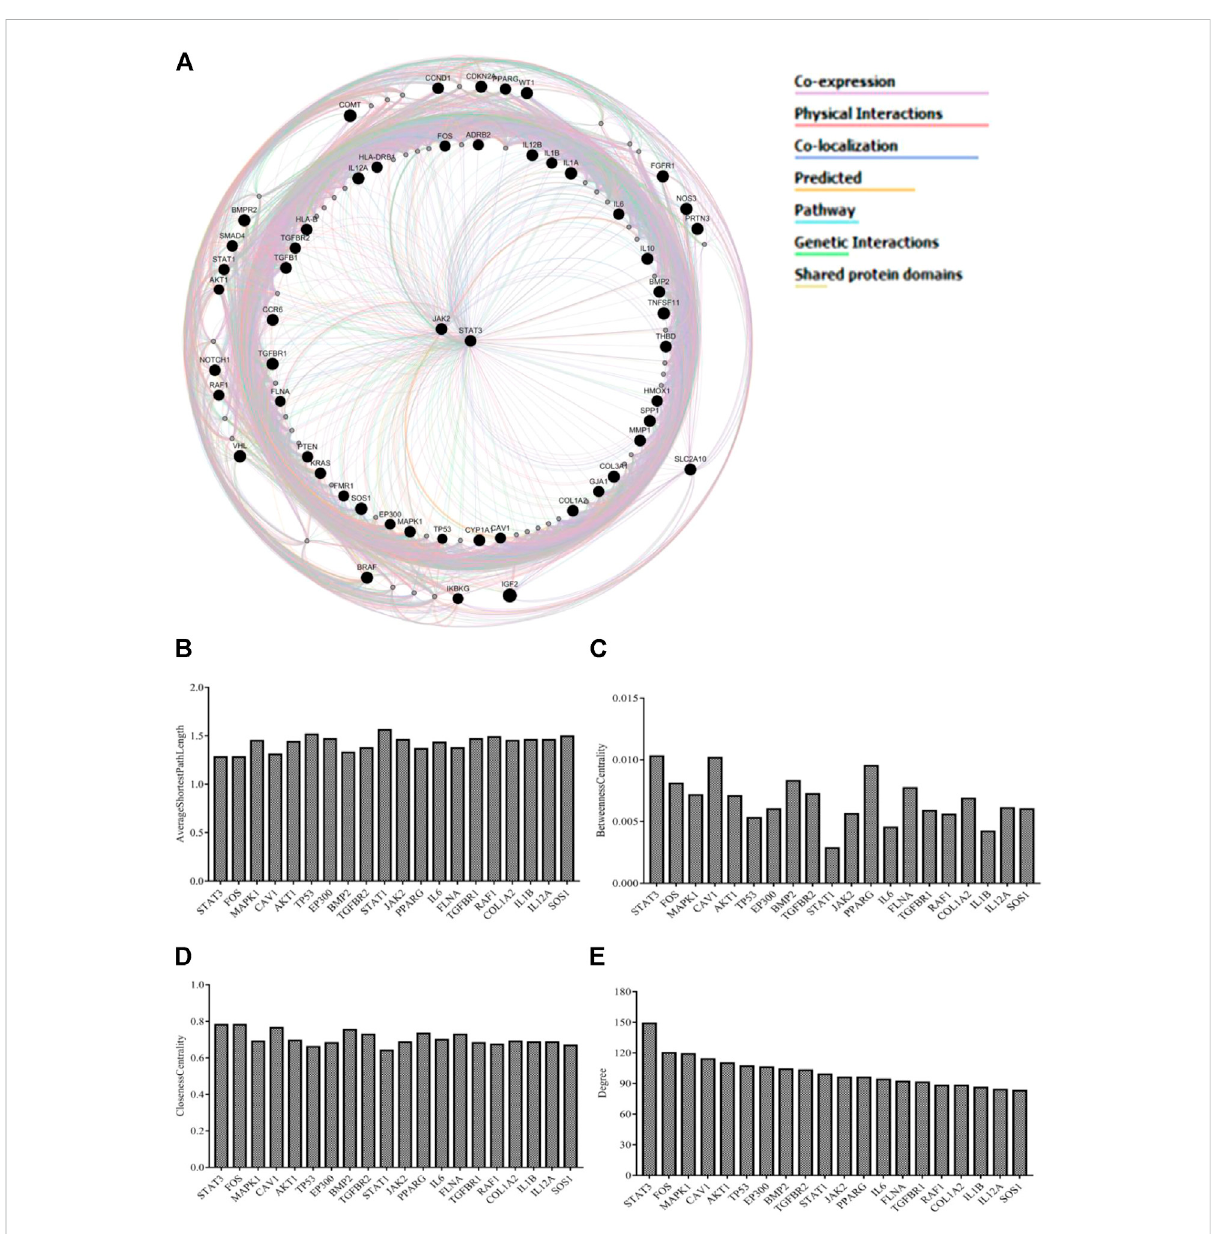
FIGURE 2 (A) GeneMANIA investigated a network of potential quercetin targets against EH. Black-colored genes were used as search terms. Genes associated to query genes are represented by nodes with a lighter black color. Various colors of connecting lines re fl ect various interrelations, and different functional associations of targets were investigated. The legends in the network shows the types of source networks are grouped together (B – E) Topological parameters of the